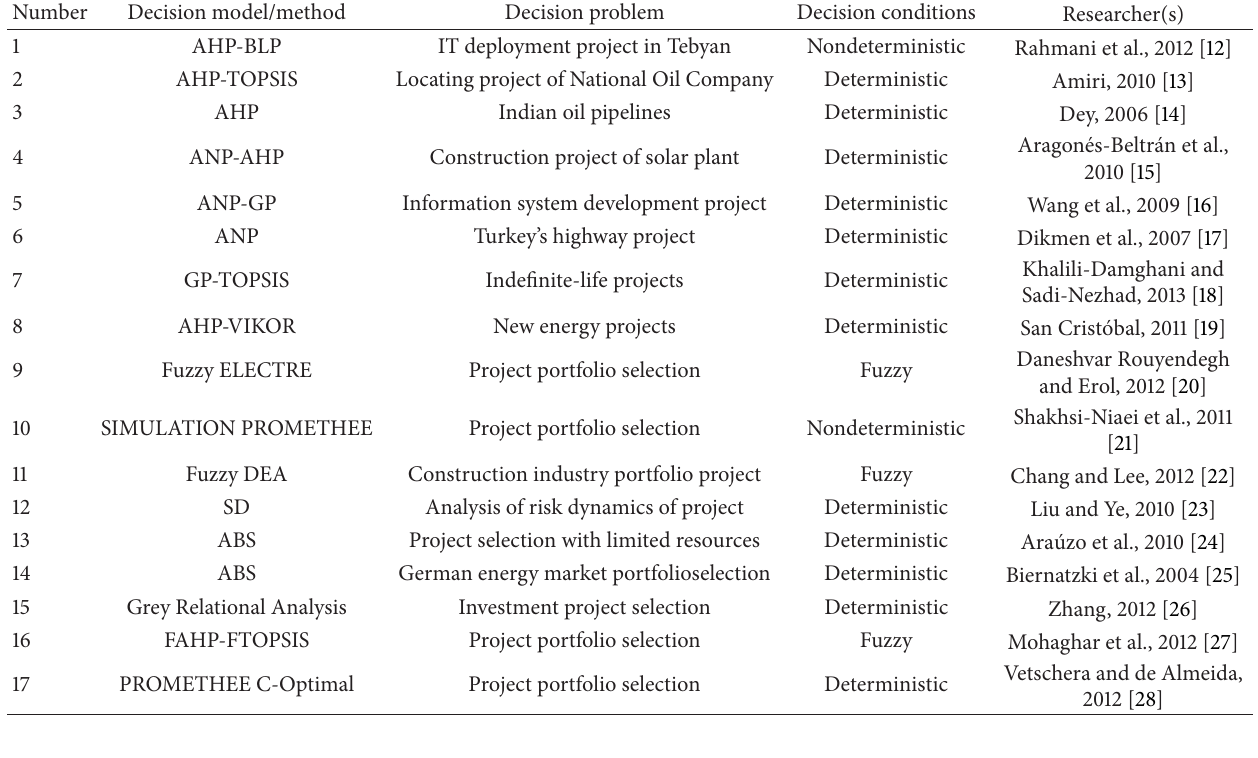
Table 1: A summary of the previous studies on project portfolio selection.